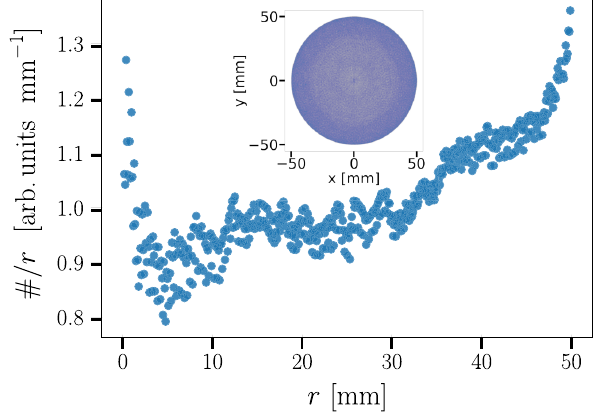
FIG. 2. Radial r dependence of blackbody radiation photon counts (normalized by 1 =r ) in a circular pipe. A reflectivity of 97% is used, with a random noise factor added to each reflection to simulate surface roughness (with a maximum of (cid:3) 0 . 5 °). Shown is a single-particle trajectory over 200 000 reflections with a 0.5 ps time step, with absorption triggering immediate reemission from a random point on the pipe diameter. Photon emission angles are generated using a beta distribution with α ¼ 1 . 65 , β ¼ 1 . 65 from − π = 2 to π = 2 radians. Inset shows the same trajectory in a plane transverse to the beam